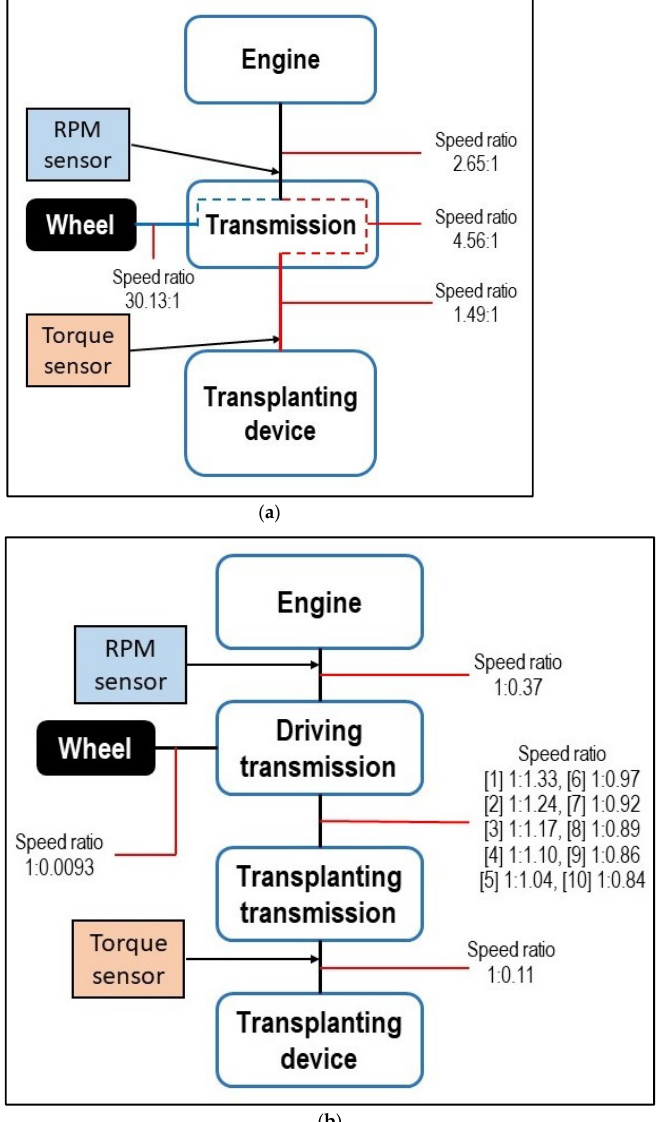
Figure 8. Reduction gear ratio of the transmission system: ( a ) cam and ( b ) four-bar-link types. The strain sensors comprised 15 strain gauges attached to the main loading paths of the transplanting device to measure the stress during transplanting. Two types of strain gauges were used: a uniaxial strain gauge (KFGS-5-350-C1-11 L10M3R, KYOWA) to measure one-directional strain in the main loading direction, such as at linkages, and a